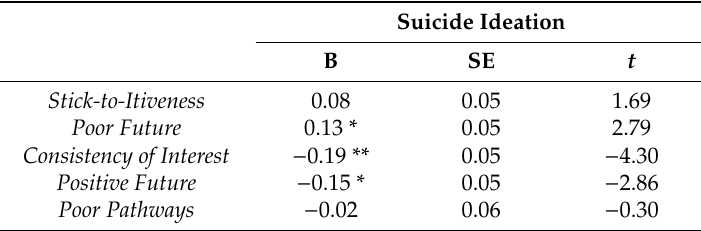
Table 6. Multiple Regression Analysis of the Five Retained Factors and Suicide